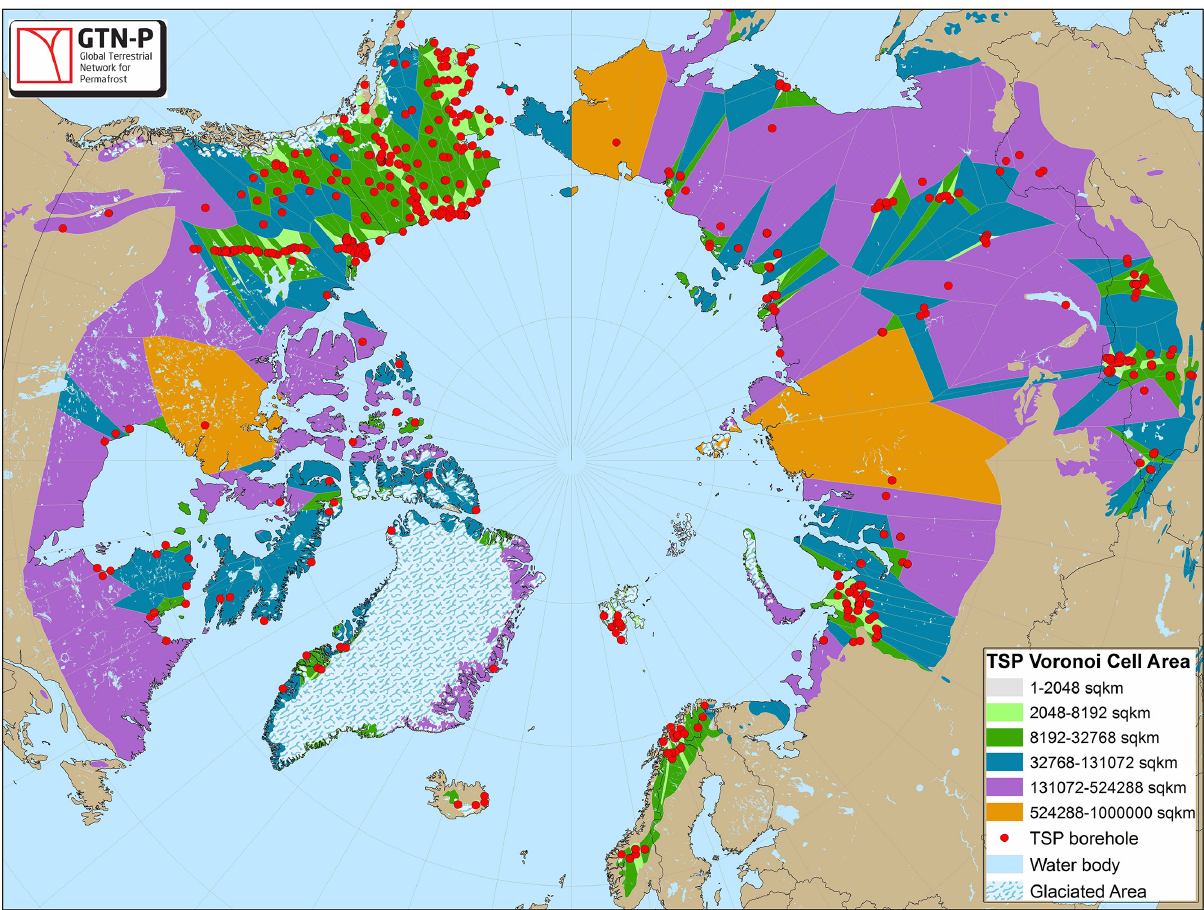
Figure 4. Voronoi tessellation analysis on the distribution of TSP boreholes in the Arctic.